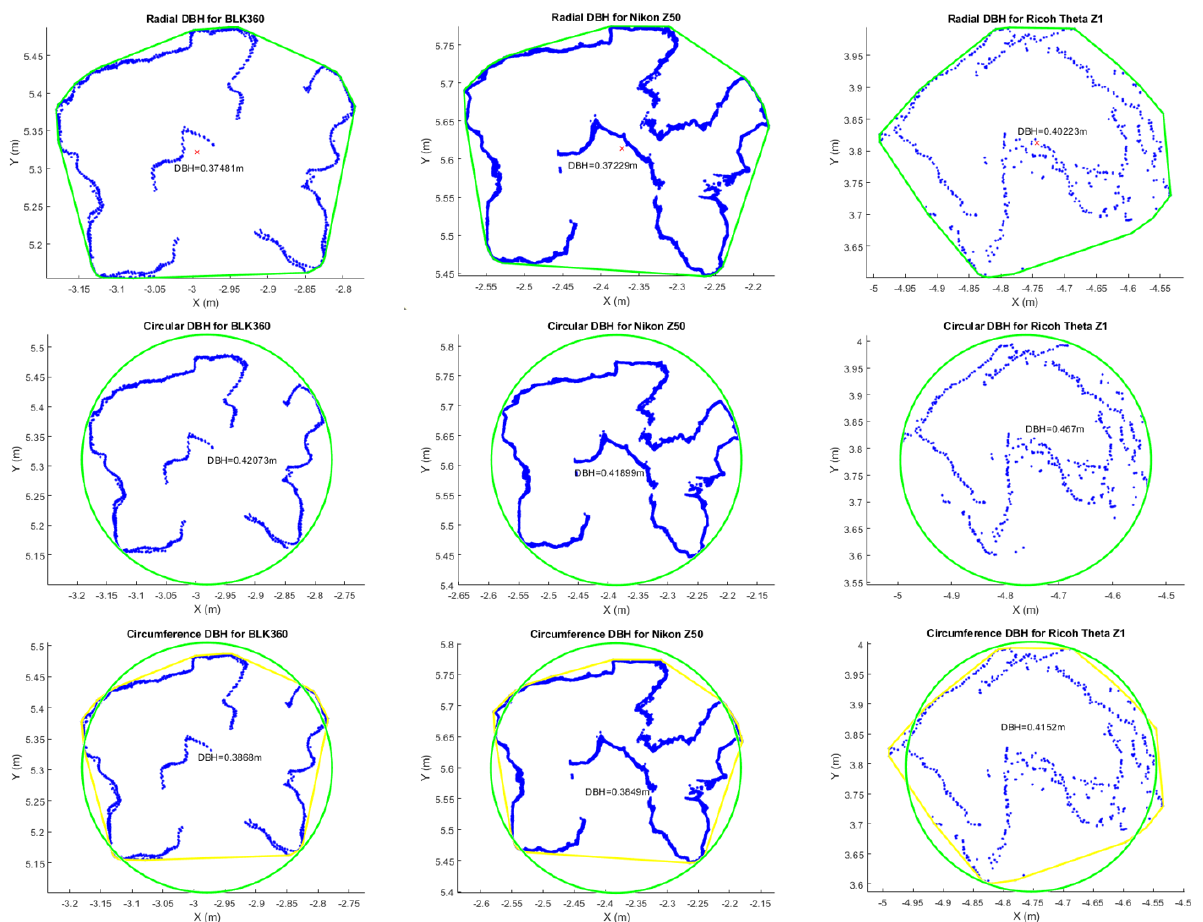
Figure 8. DBH computation using three different methods employed on the three different